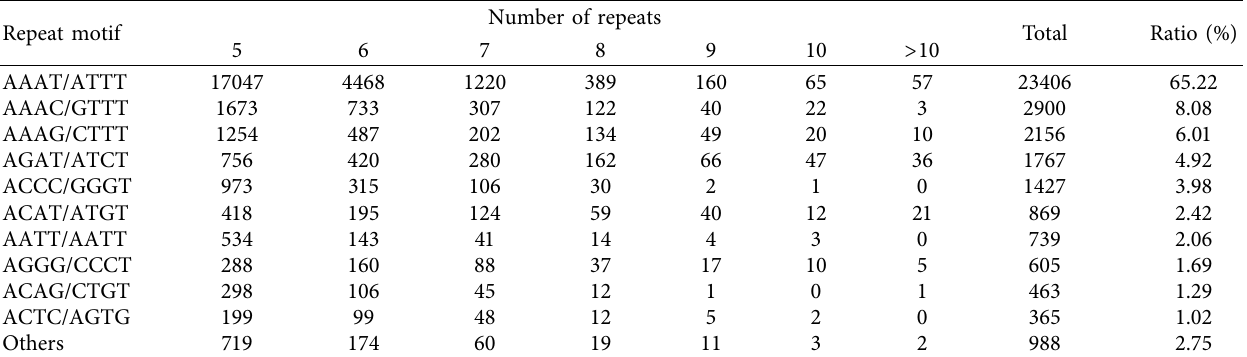
Table 7: Statistics of tetranucleotide 35, 890 motifs.